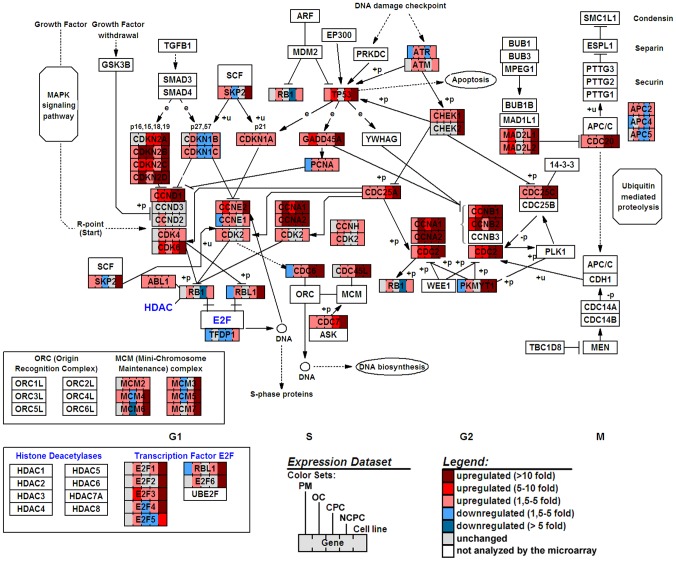
Gene map of cell cycle genes differentially expressed by human corneal endothelial cells in six biological models.Post mortem (PM), corneal organ culture (OC), in vitro confluent primary culture (CPC), in vitro non-confluent primary culture (NCPC), and immortalized endothelial cell line (ECL). Results were compared with in vivo endothelial cells. The representation of the pathway was generated by GenMAPP version 2.1 (http://www.genmapp.org/) using the cell cycle pathway provided by KEGG.